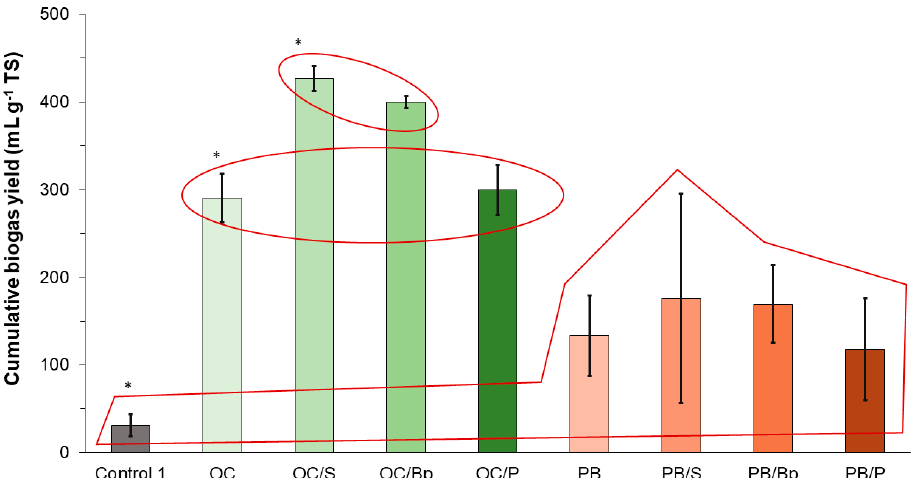
Figure 9. Cumulative yield of produced biogas after 24 days in different bioreactors as listed in Table 1 (N = 3). * Values that do not differ significantly ( p < 0.05) are circled.